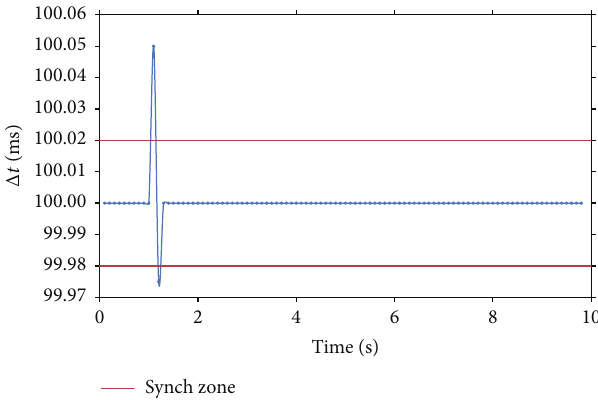
Figure 10: Interarrival times of sync messages to the slave. Constant delay, 𝑑 adv = 50 𝜇 s.